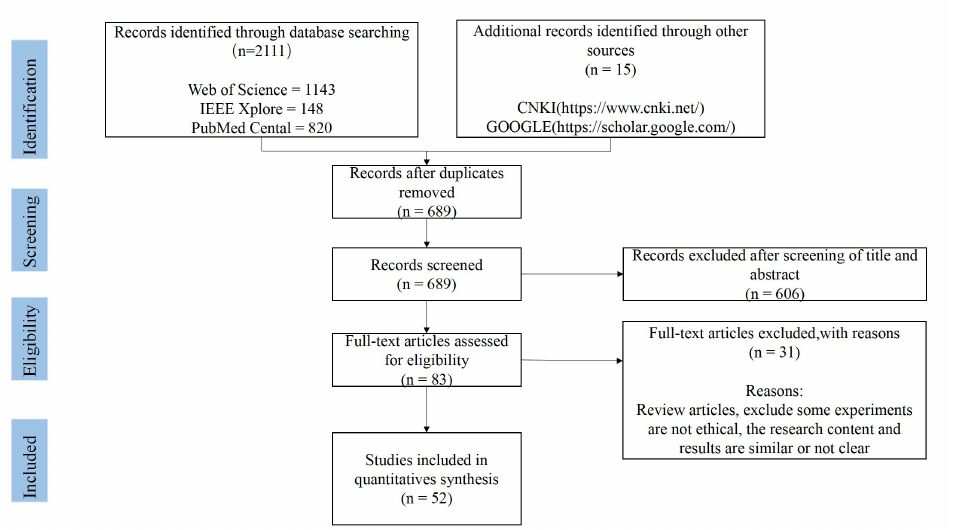
Figure 1. Flow diagram of the literature review